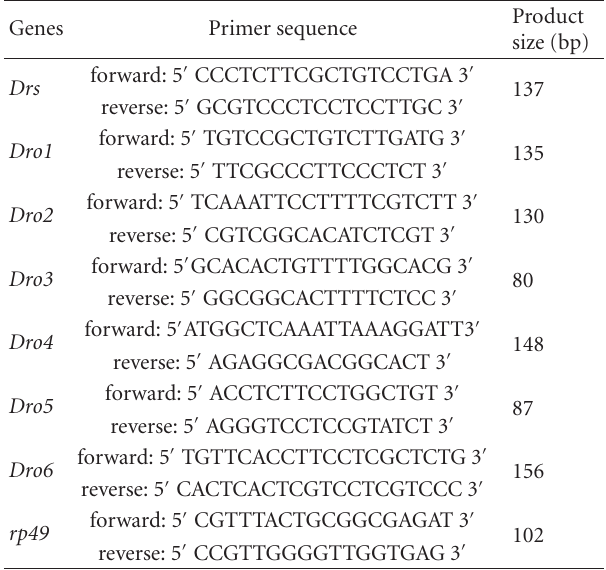
Table 1: Primers for RT-PCR and real-time PCR.